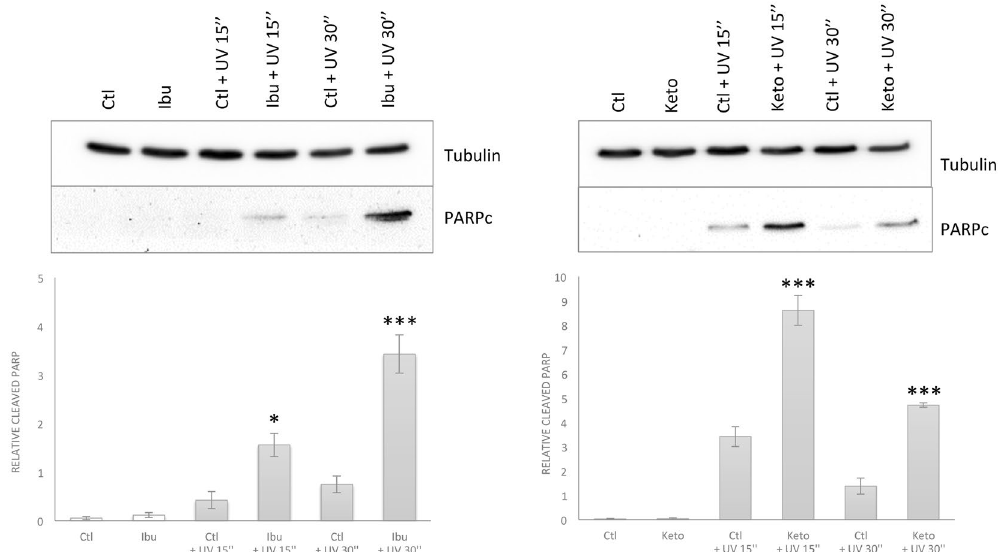
Figure 3. Ibuprofen (left) and ketoprofen (right) enhanced UV induced cell death. Cell death was evaluated by the detection of the cleaved PARP by western blotting on MCF-7 cells untreated (ctl) or treated with 500 µ M of ibuprofen/ketoprofen (ibu/keto) as described in Fig. 2. 50 µ g of total cell lysate was used. Detection of tubulin corresponds to the loading control. Significance of untretaed vs ibuprofen or ketoprofen treated cells are represented with * for P < 0.05, ** for P < 0.01, *** for P < 0.001. The full-length blots are presented in Supplementary Information (Figures S10 and S11).